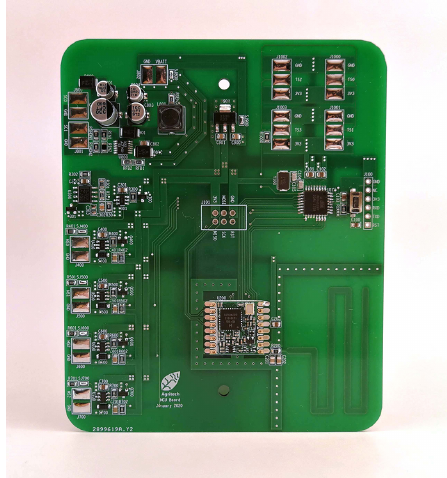
Figure 4. HTMWE electronic circuits, board and partial